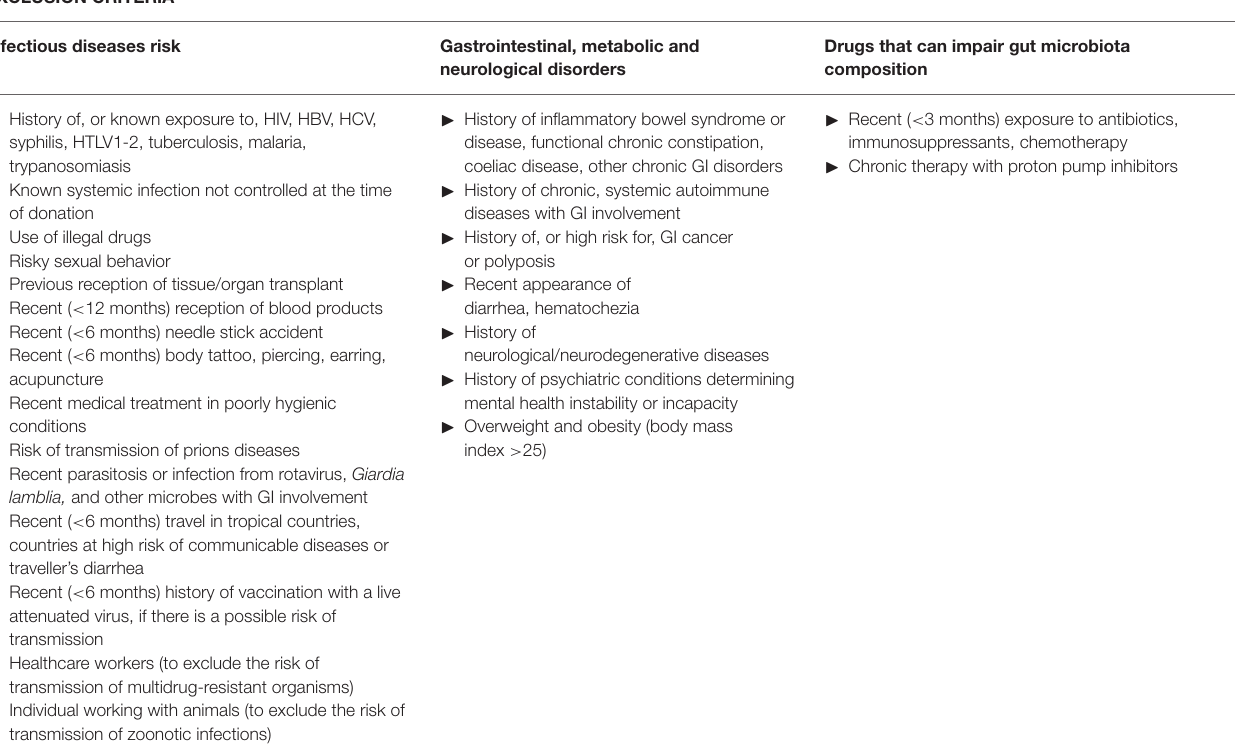
TABLE 2 | Criteria for donors’